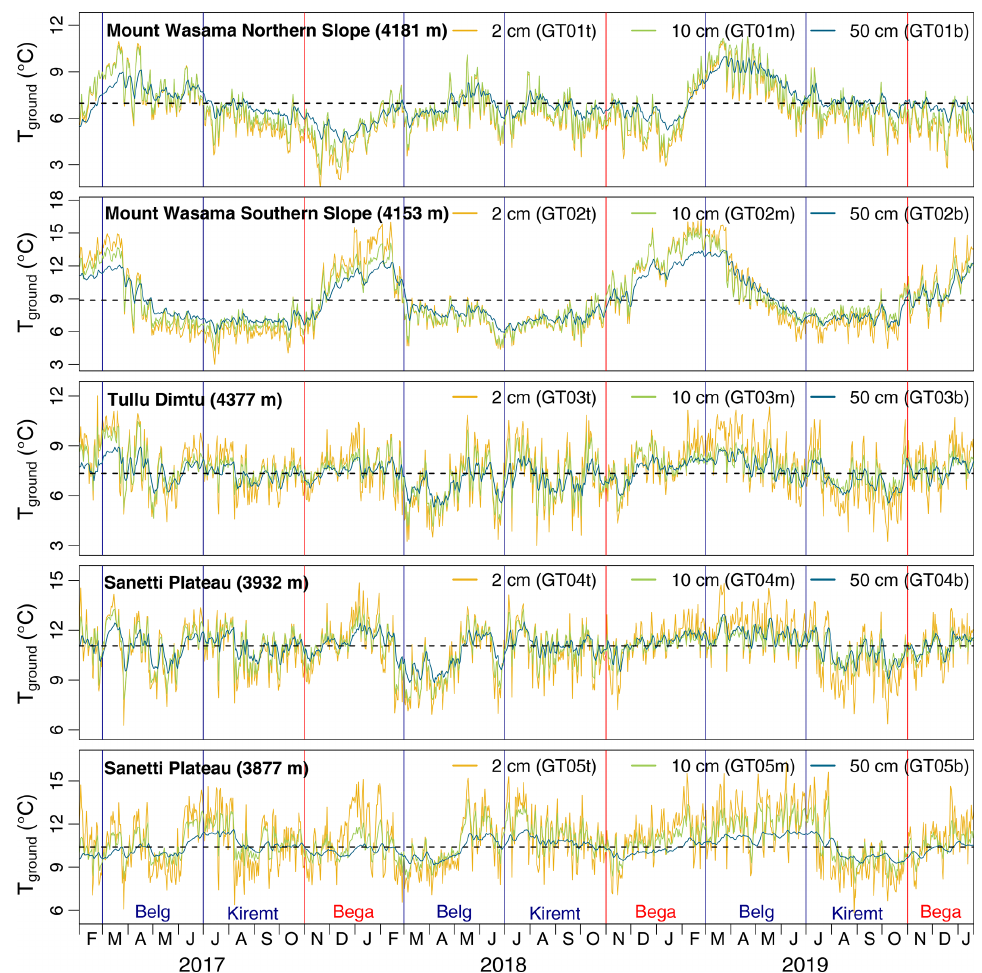
Figure 4. Aggregated mean daily ground temperature at 2, 10, and 50cm depth on Mount Wasama, Tullu Dimtu, and the Sanetti Plateau from 1 February 2017 until 20 January 2020. The dashed horizontal lines indicate the average ground temperature (integrated over depth) at each site during the measurement period. The vertical lines indicate the onset of the different seasons (blue: rainy season; red: dry